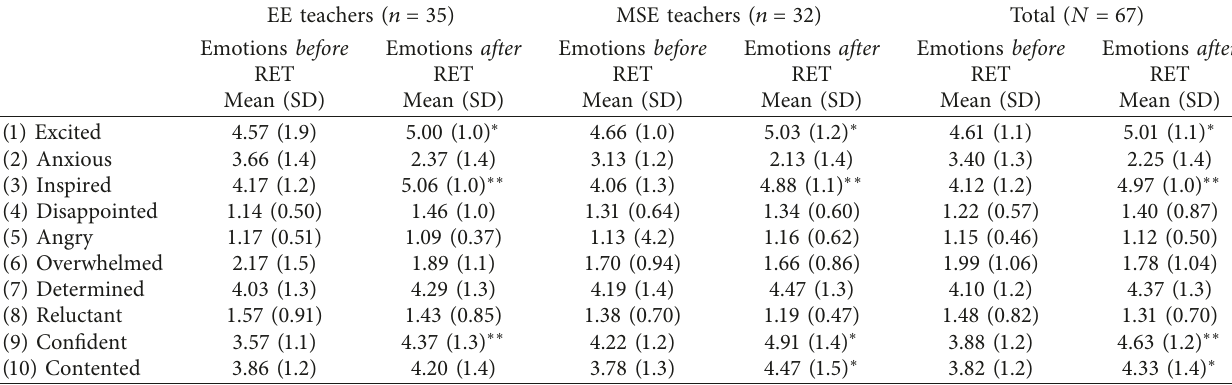
Table 2: Teachers’ reported emotions (before and after RET